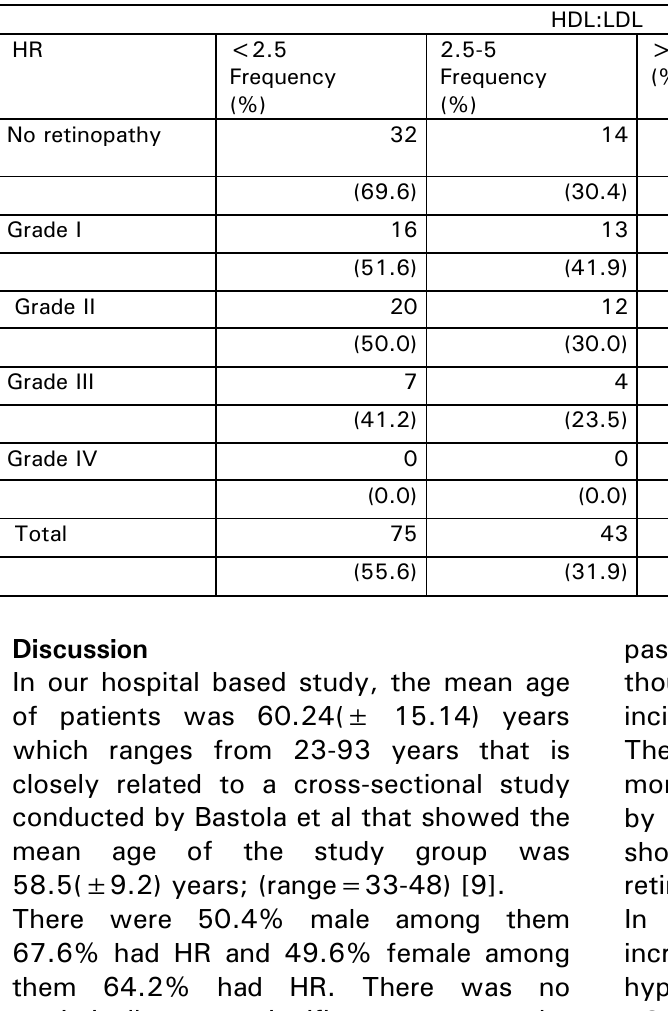
Table 10 Association with